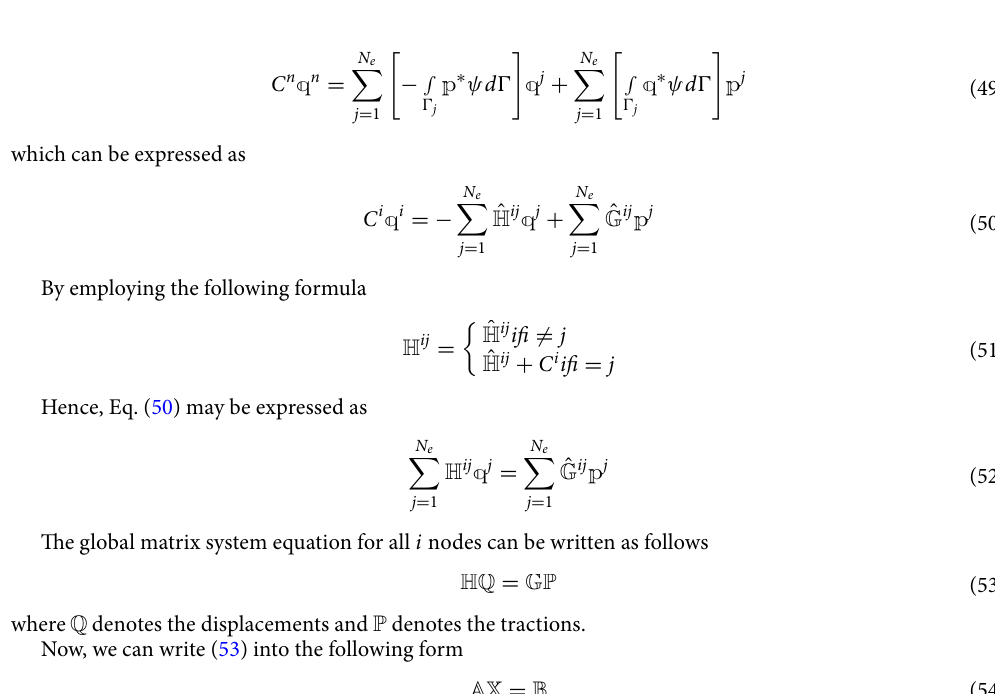
Figure 2. Boundary element model of the considered